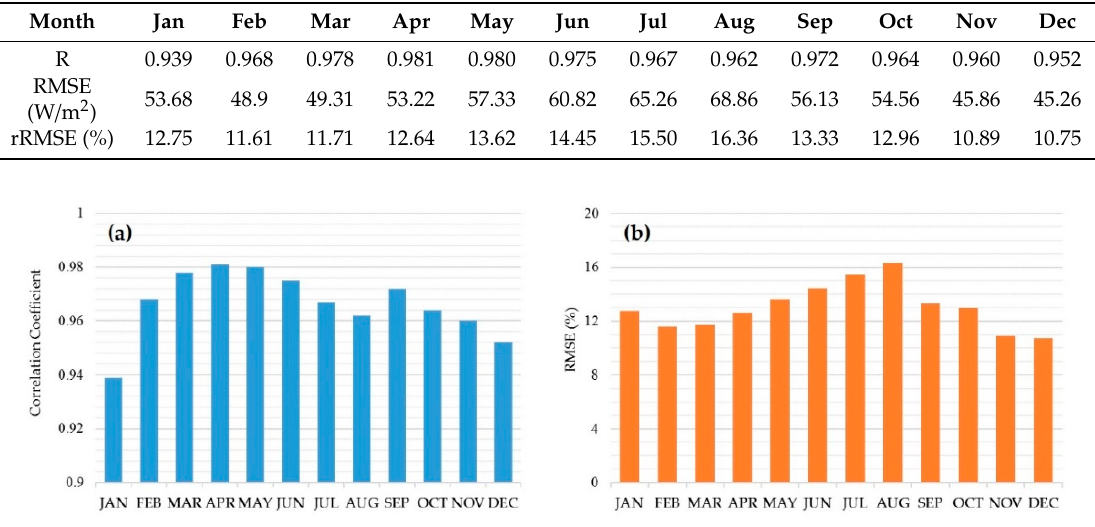
Figure 8. Monthly accuracy of the temporal validation of the ANN model represented by ( a ) R and ( b ) rRMSE (%) . Table 3. Monthly accuracy of the temporal validation of the ANN model.